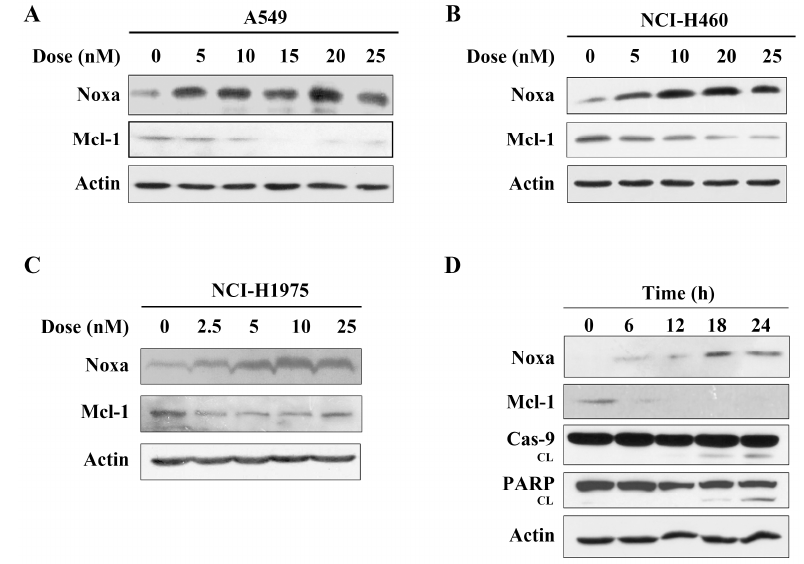
Figure 3. Arenobufagin up-regulates Noxa and down-regulates Mcl-1 in NSCLC cells. ( A , B ) A549 and NCI-H460 cells were incubated with the indicated concentrations of arenobufagin for 24 h, and the protein expression levels of Noxa, Mcl-1, and Actin were determined by Western blotting. The level of actin was used as a loading control; ( C ) Noxa up-regulation and Mcl-1 down-regulation were determined using a Western blot analysis in NCI-H1975 cells; ( D ) A549 cells were treated with arenobufagin at 20 nM for the indicated time points, and the expression of Noxa, Mcl-1, caspase-9, PARP and Actin were analyzed by Western blotting. The level of actin was used as a loading control. 2.4. Noxa is Required for the Inhibition Effect of Arenobufagin on NSCLC Cells